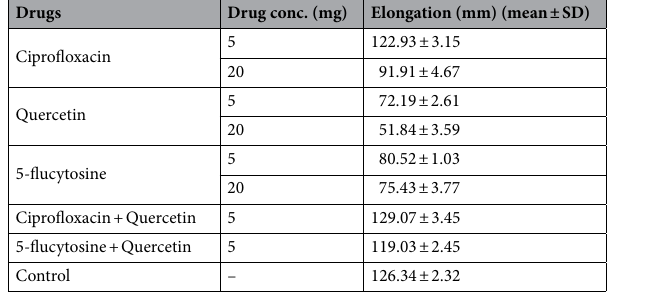
Table 3. Elongation property of the